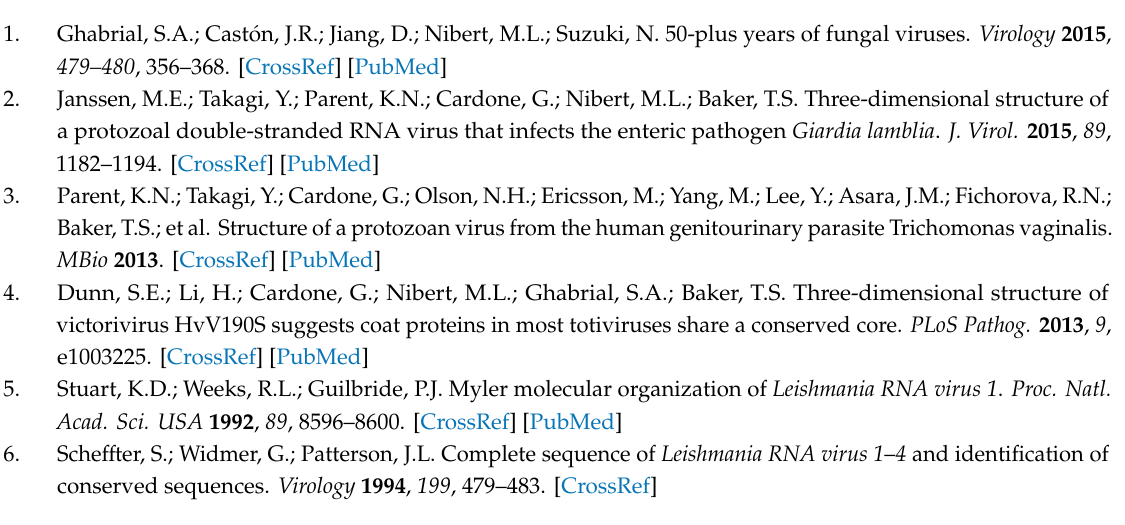
Figure S1: Singleton indels in LRV2-Lmj-ASKH (U32108.1) resulting in frame shifts. A. Nucleotide sequences of three clades of Leishmania LRVs (LRV1, LRV2-Lae, and LRV-Lmj) were aligned using MAFFT Eins-i and visually inspected in BioEdit. Alignment columns with ≥ 50% similarity in analyzed species are colored. Nucleotide positions, which correspond to insertions in LRV2-Lmj-ASKH sequence, are numbered. In cases of deletion, two consecutive nucleotide positions are numbered B. Amino acid sequence alignment of LRV2-Lmj-ASKH and LRV2-Lm-Uzb1 showing the frame-shifted regions corresponding to nucleotide sequences shown in panel